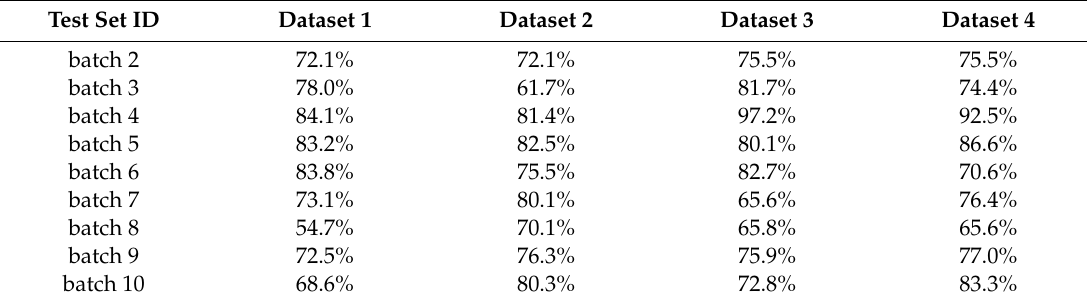
Table 8. Classification Accuracy of the Improved LSTM Model under Four Datasets.